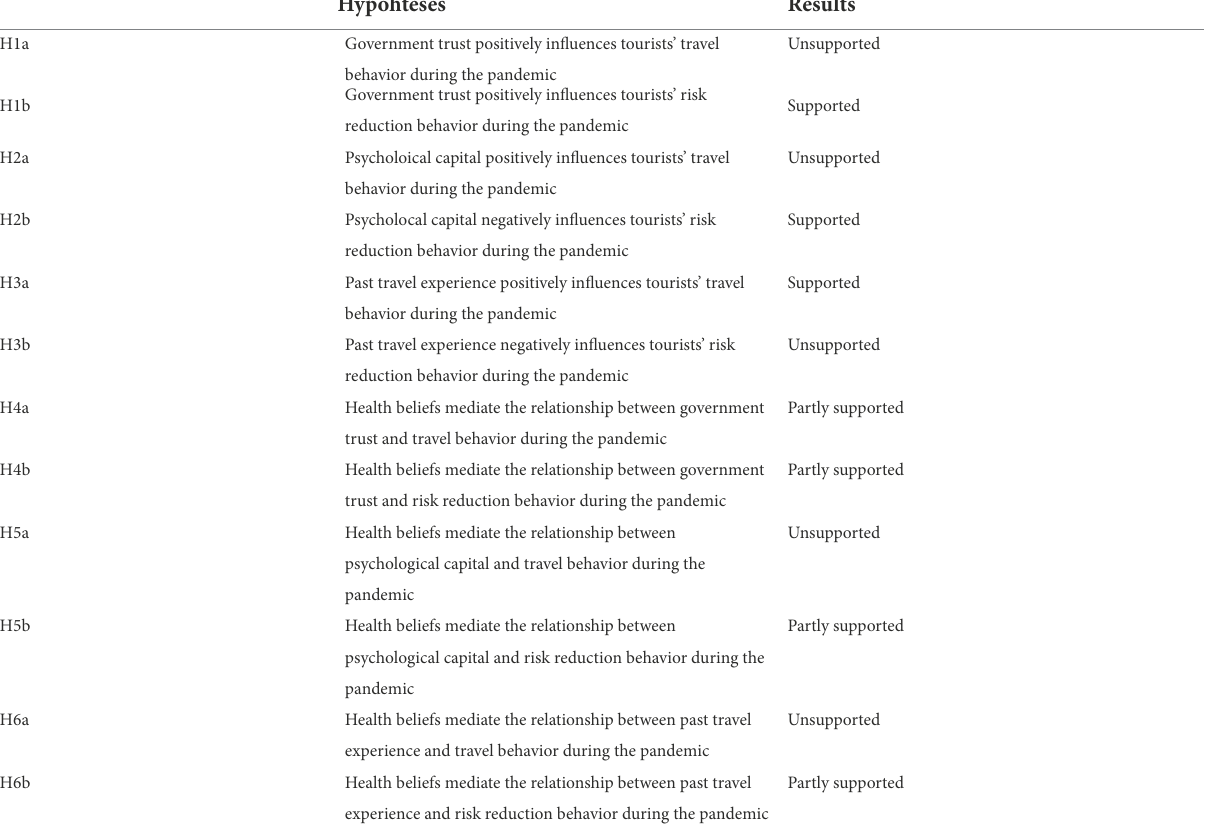
TABLE 4 Summary of hypotheses testing